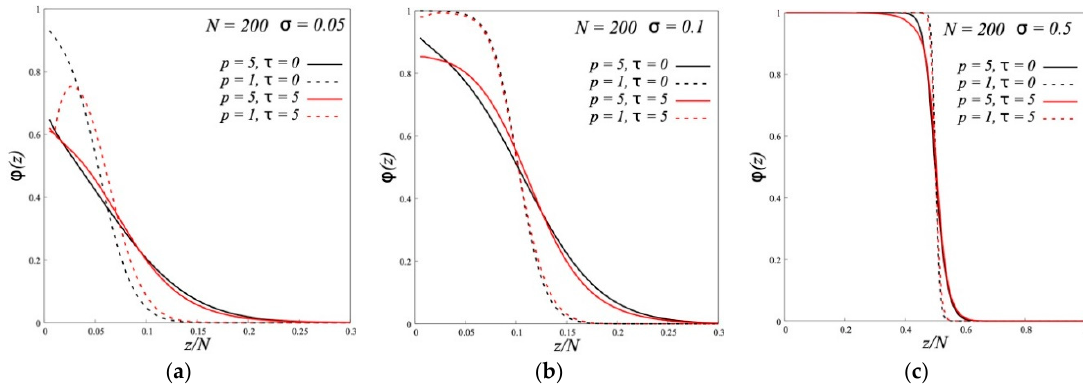
Figure 1. The volume fraction profiles ϕ ( z ) of polymer brushes with different stiffness of the grafted chains ( p ) and different values of the parameter of dipole-dipole interactions ( τ ) in melt of the same chains at grafting densities σ = 0.05 ( a ), σ = 0.1 ( b ) and σ = 0.5 ( c ).